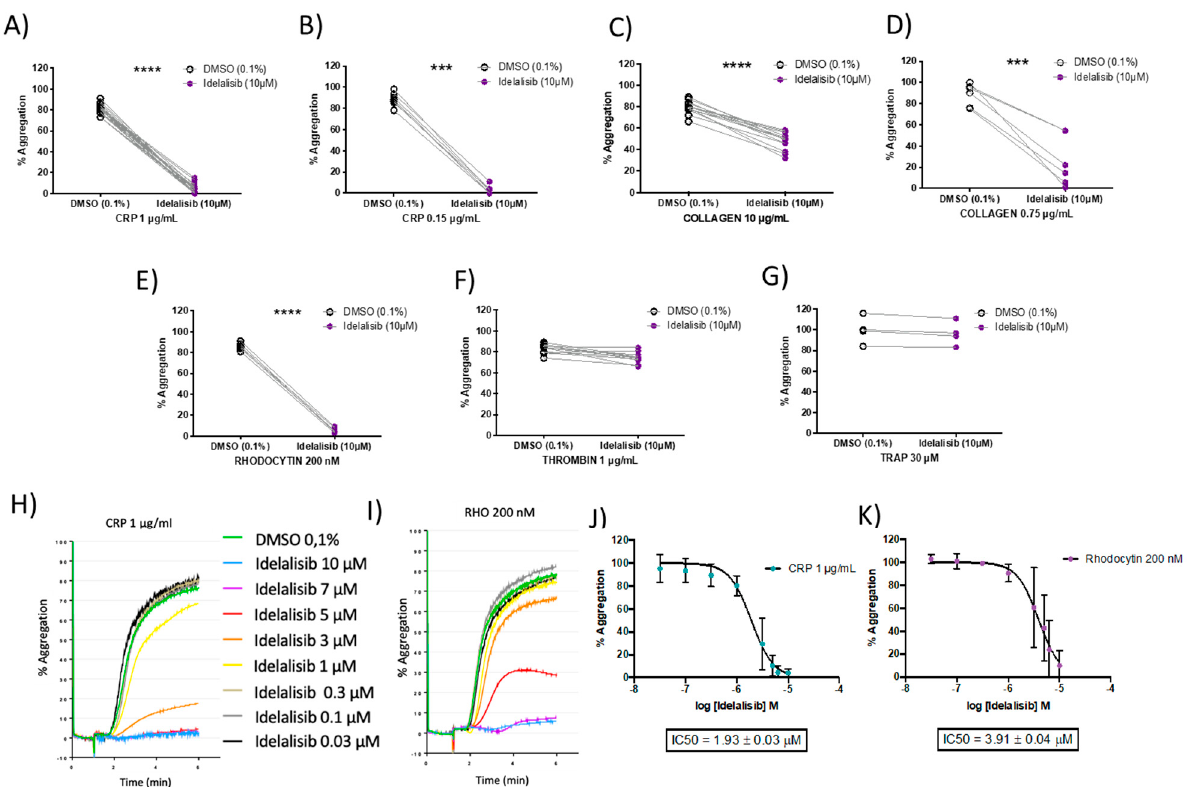
Figure 2. Idelalisib inhibits GPVI-and CLEC-2-mediated platelet aggregation in a dose-response manner. Aggregation profiles upon platelet activation, in presence and absence of Idelalisib, with the following agonists at the indicated doses: ( A ) CRP (washed platelets); ( B ) CRP (platelet-rich-plasma (PRP)); ( C ) collagen (washed platelets); ( D ) collagen (PRP); ( E ) Rhodocytin (washed platelets); ( F ) thrombin (washed platelets); ( G ) thrombin receptor activating peptide (TRAP) (PRP). Effect on aggregation percentage was evaluated in N = 22 (CRP, 1 µ g/mL), N = 13 (Collagen, 5 µ g/mL), N = 6 (Rhodocytin, 200 nM), and N = 11 (Thrombin, 0.1 U/mL), in washed platelets; and N = 7 (CRP, 0.15 µ g/mL), N = 7 (Collagen, 0.75 µ g/mL), and N = 4 (TRAP, 30 µ M) in PRP. H-K) Dose-response efficacy of Idelalisib at inhibiting platelet aggregation following platelet activation in washed platelets with both CRP and Rhodocytin, leading to the determination of IC 50 values. *** p < 0.001; **** p < 0.0001. ( H , I ) show representative aggregation curves, while ( J , K ) plots represent for each concentration used the average of 6 independent measurements from 6 different donors and the error bars are the standard error of the mean.